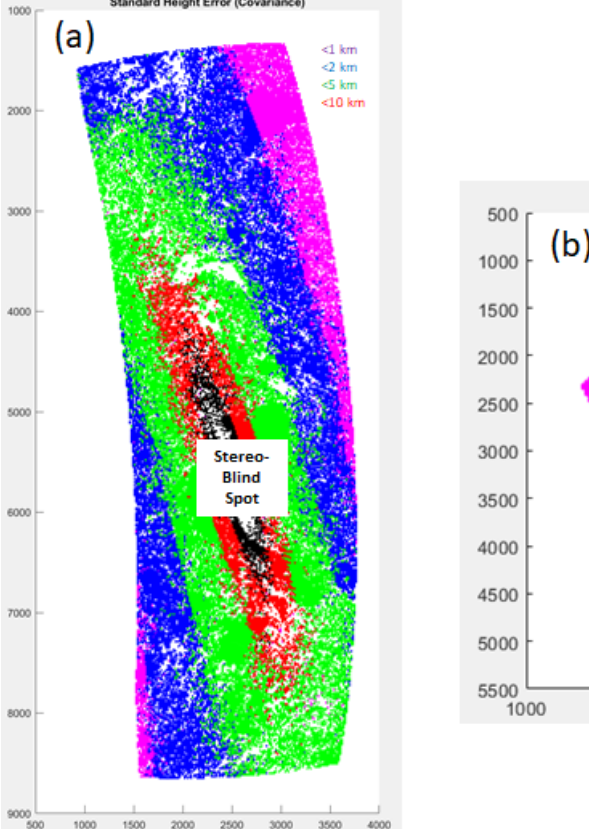
Figure 4. Theoretical height retrieval uncertainties for tandem ( a ) and crossing ( b ) cases from Figures 2 and 3 respectively. Assumed disparity measurement errors are 0.5 km 1-sigma. Black indicates e ff ective loss of stereo acuity (>10 km uncertainty). Only retrievals meeting peak correlation and residual quality criteria are plo tt ed. Coordinate distance is in kilometers.